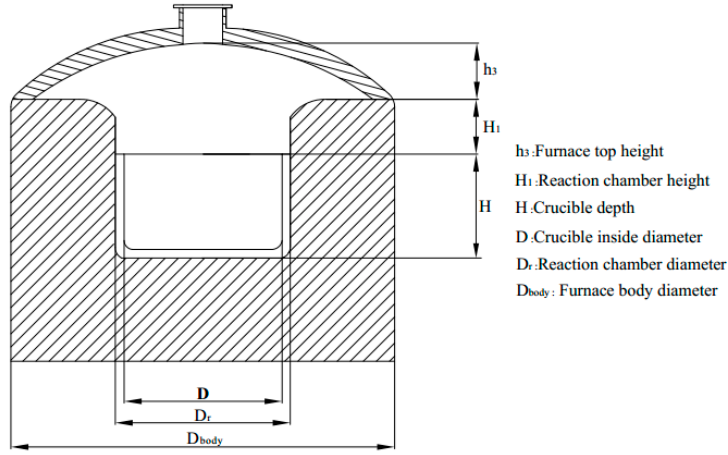
Figure 5. Schematic diagram of the arc furnace with dimensions.